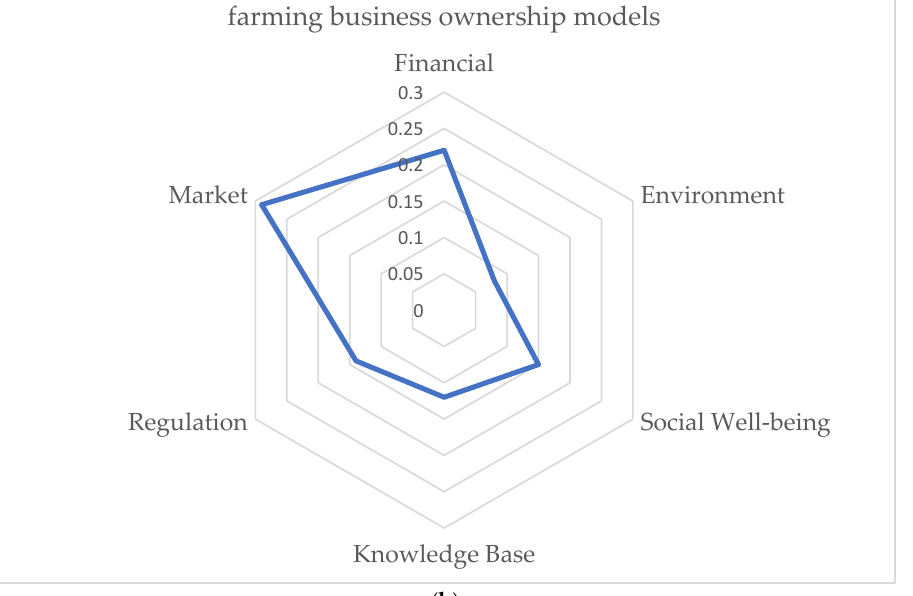
Figure 2. ( a ). Relative importance of the main domains in influencing land-use decision making for each farming ownership model. ( b ). Relative importance of main domains across all farming ownership models.